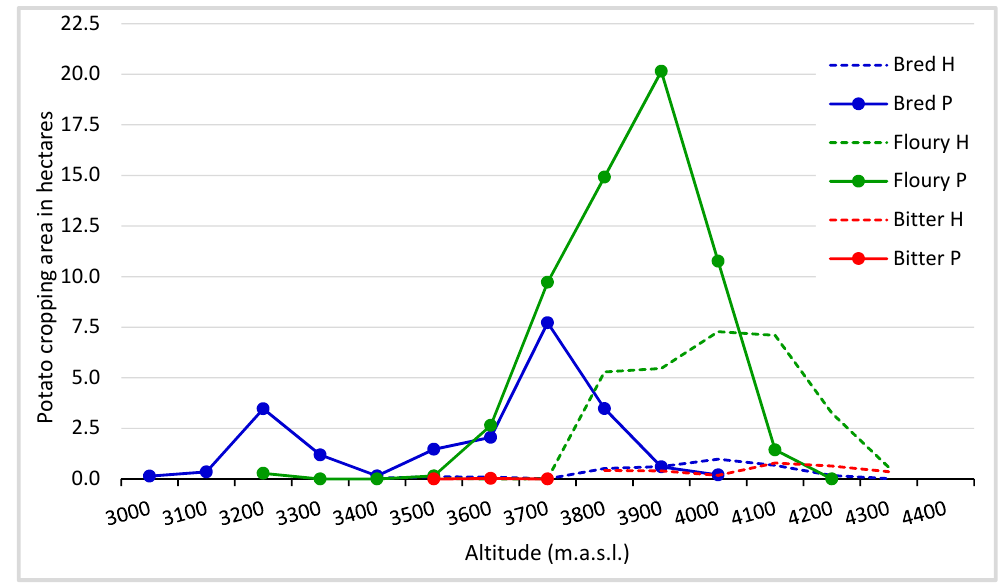
Figure 3. Total potato cropping area by cultivar group (bred, floury, bitter) and landscape (Huancavelica = H, Pasco = P) across the altitudinal range from 3000 to 4400 m.a.s.l. We also examined the number of cultivars per field for incremental 100-m altitudinal belts in each landscape. In Huancavelica, the highest concentration of cultivars occurred at the 4000–4100 m altitudinal belt with an average 37.0 (± 12.7) and maximum 46 cultivars per field. These were floury, bitter, and bred cultivars. This was the case at 3900–4000 m with an average 22.3 (± 11.6) and maximum 50 cultivars per field in Pasco, involving only floury landraces and bred varieties. The highest levels of within-field diversity are concentrated at the upper limits.